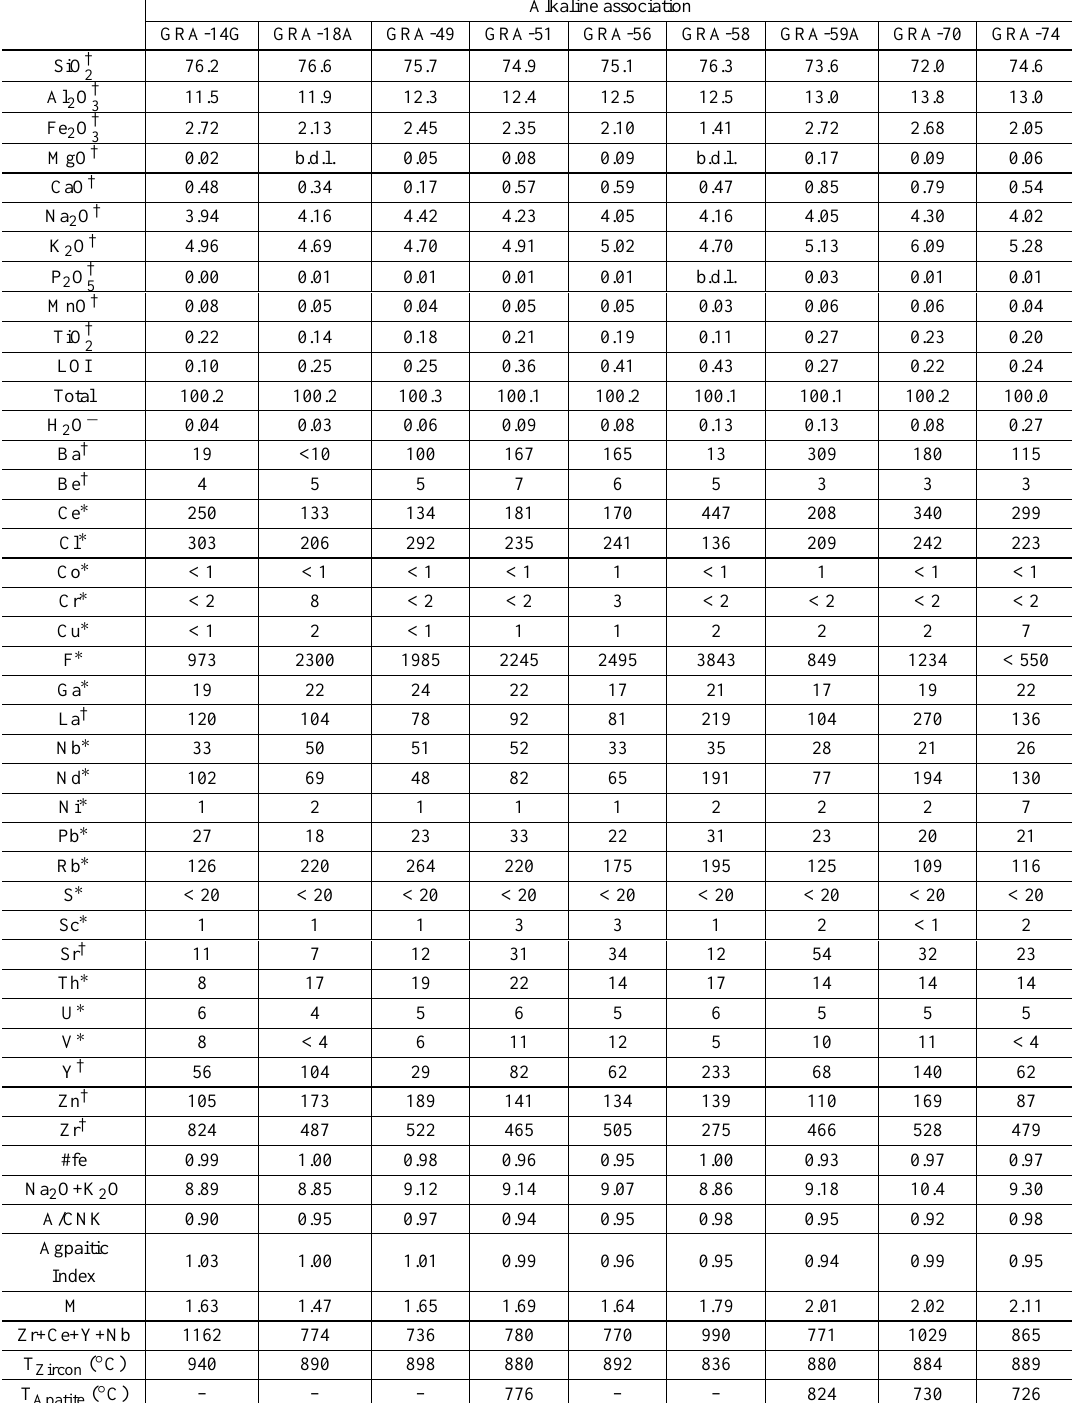
Whole-rock chemical data for the Serra da Graciosa granites, syenites, and related monzodioritic rocks (oxides: wt.%, trace elements: ppm, LOI: Lost on Ignition, A/CNK and Agpaitic Index defined in Figure 2). Alkaline